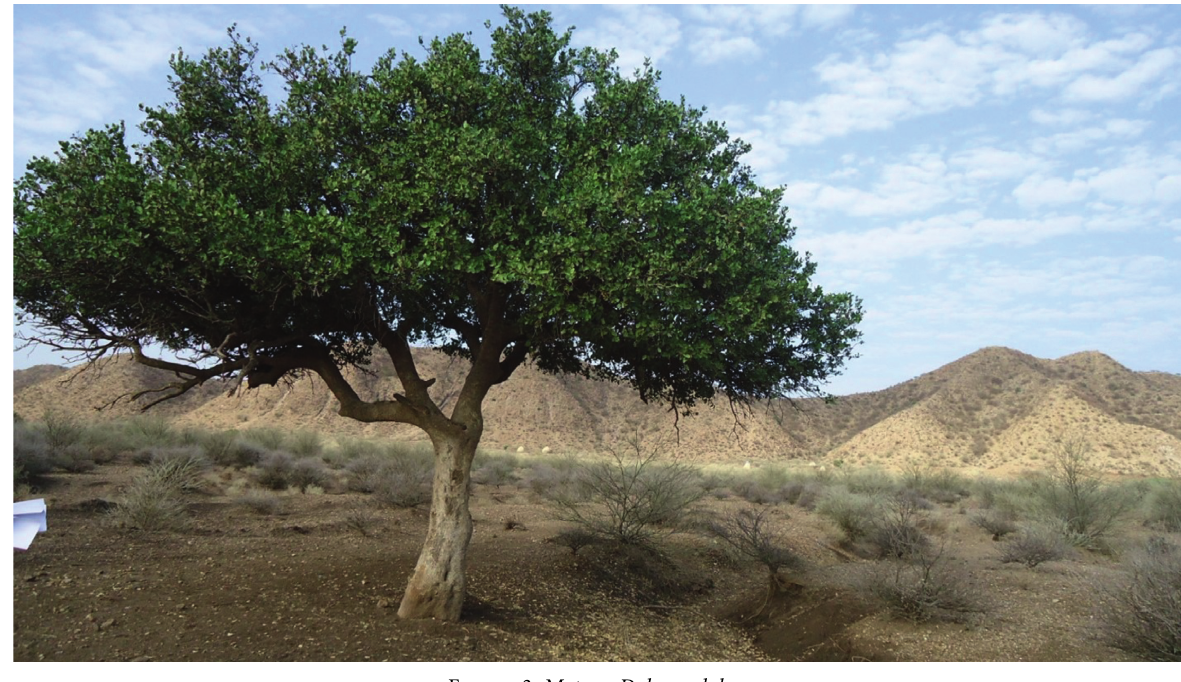
Figure 3: Mature Dobera glabra